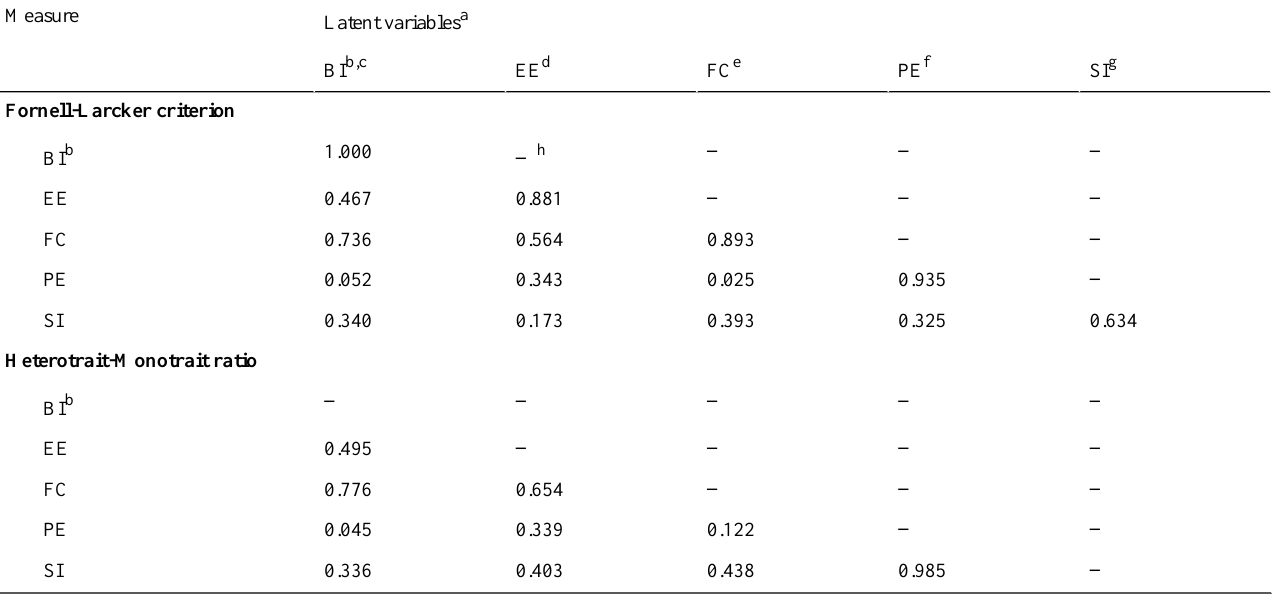
Table 5. Discriminant validity.